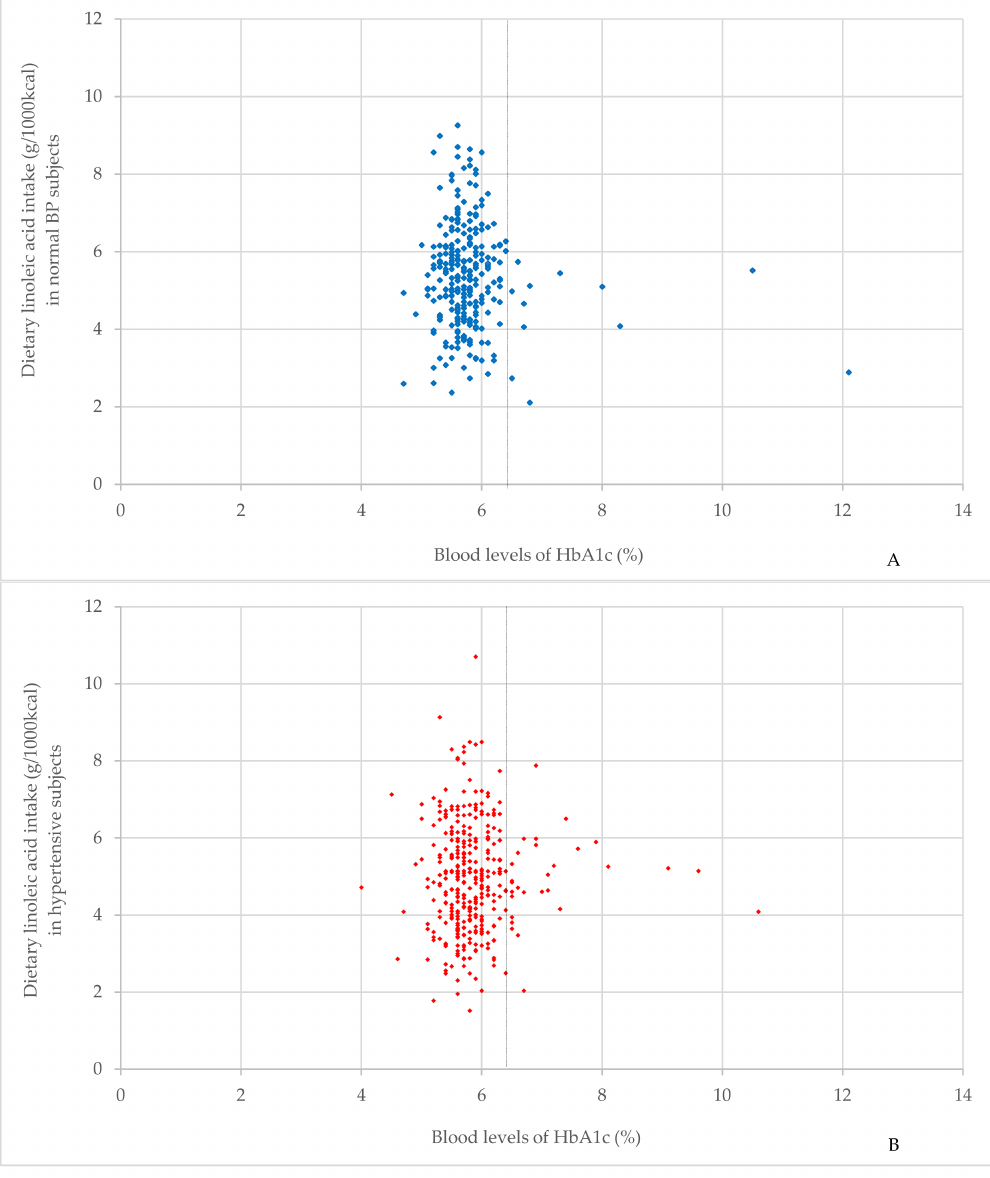
Figure 2. The spread of relationship between dietary linoleic acid intake and blood levels of HbA1c. ( A ) shows the spread of the relationship between dietary linoleic acid intake and blood levels of HbA1c in normal BP subjects ( n = 283). ( B ) shows the spread of the relationship between dietary linoleic acid intake and blood levels of HbA1c in hypertensive subjects ( n = 350). The vertical dotted line indicates the cut-off for the normal HbA1c level (HbA1c = 6.5). Hypertensive subjects were defined as participants with a greater SBP than 140 mmHg, a DBP greater than 90 mmHg, or the use of antihypertensive medication. A high HbA1c level was defined as an HbA1c value of 6.5% or higher. Abbreviations: BP, blood pressure; SBP, systolic blood pressure; DBP, diastolic blood pressure; HbA1c, hemoglobin